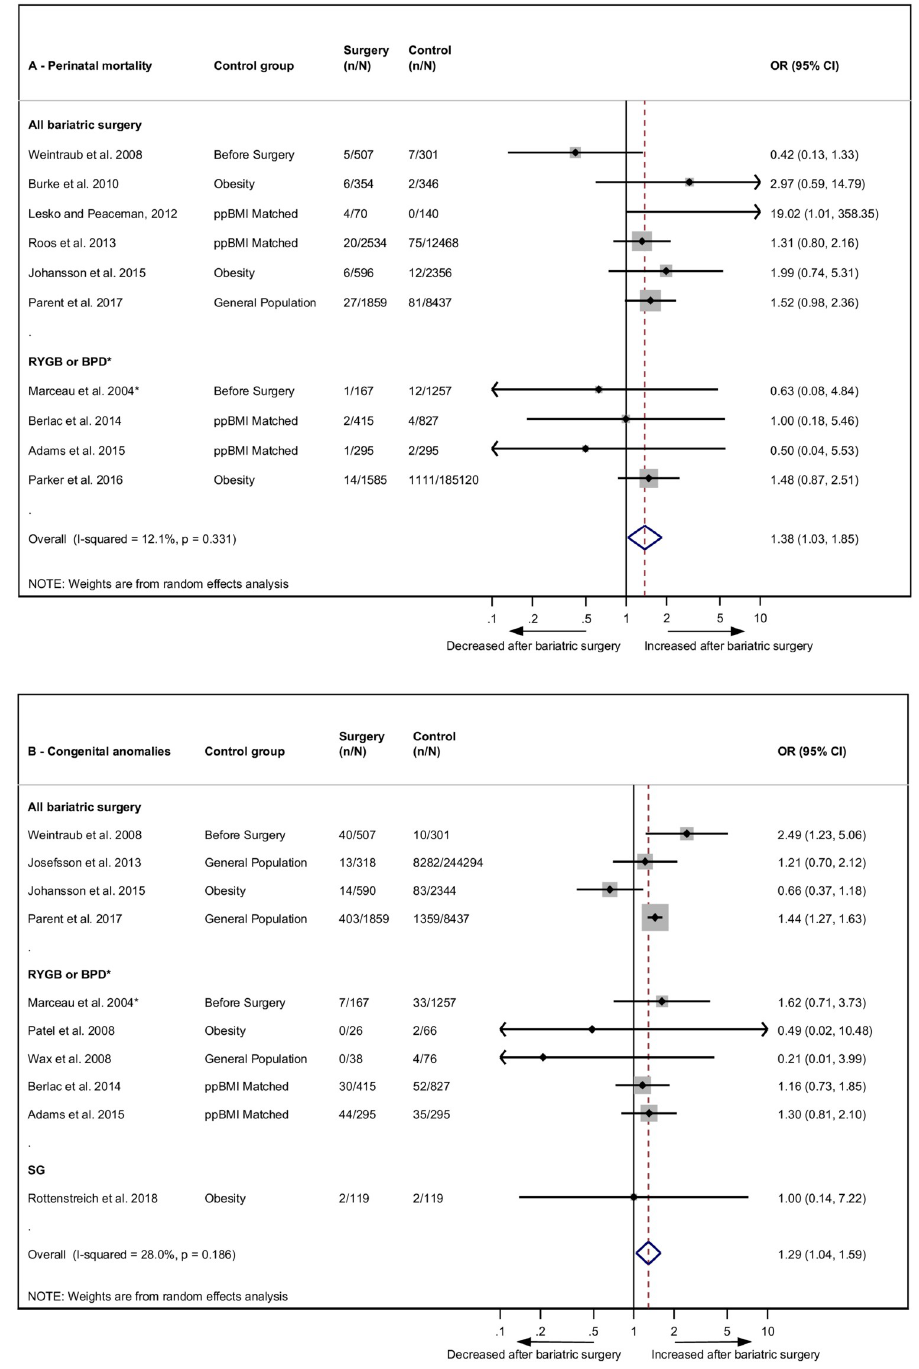
Fig 2. Perinatal mortality and congenital anomalies after bariatric surgery meta-analysis. Association between maternal bariatric surgery and (A) perinatal mortality (includes stillbirth) and (B) congenital anomalies. Studies are presented as Author, year. The forest plots are stratified by type of surgery. n = cases of perinatal mortality or congenital anomalies. N = total group size. � BPD only. BPD, biliopancreatic diversion; CI, confidence interval; OR, odds ratio; ppBMI, prepregnancy body mass index matched; RYGB, Roux-en-Y gastric bypass; SG, sleeve gastrectomy.